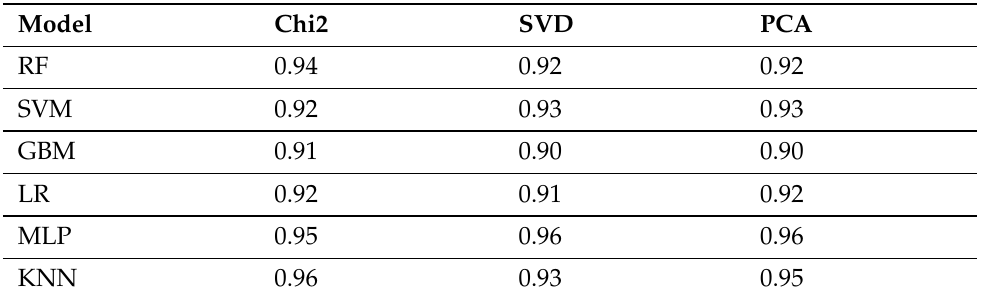
Table 7. Classification accuracy of machine learning classifiers using 15 most important